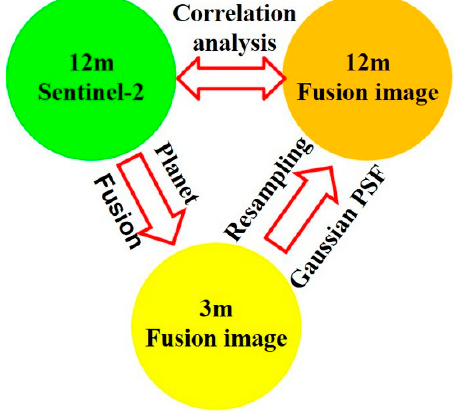
Figure 4. Image assessment via correlation analysis.